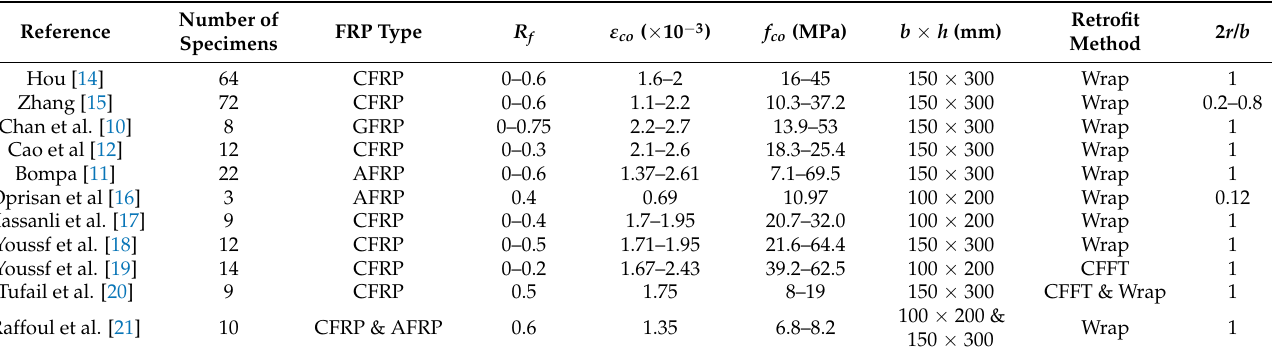
Table 1. Database for model